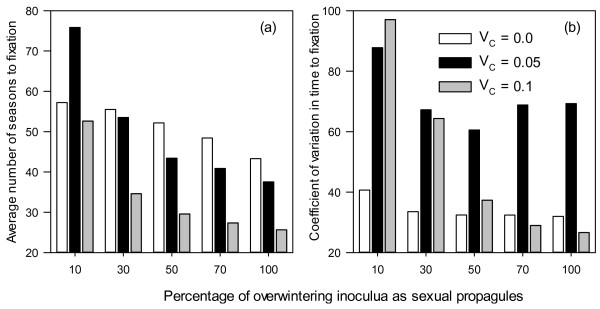
Average time (number of seasons) to fixation (a) and its coefficient of variation (b) in relation to cost of virulence and the percentage of primary inocula derived from sexual propagules.